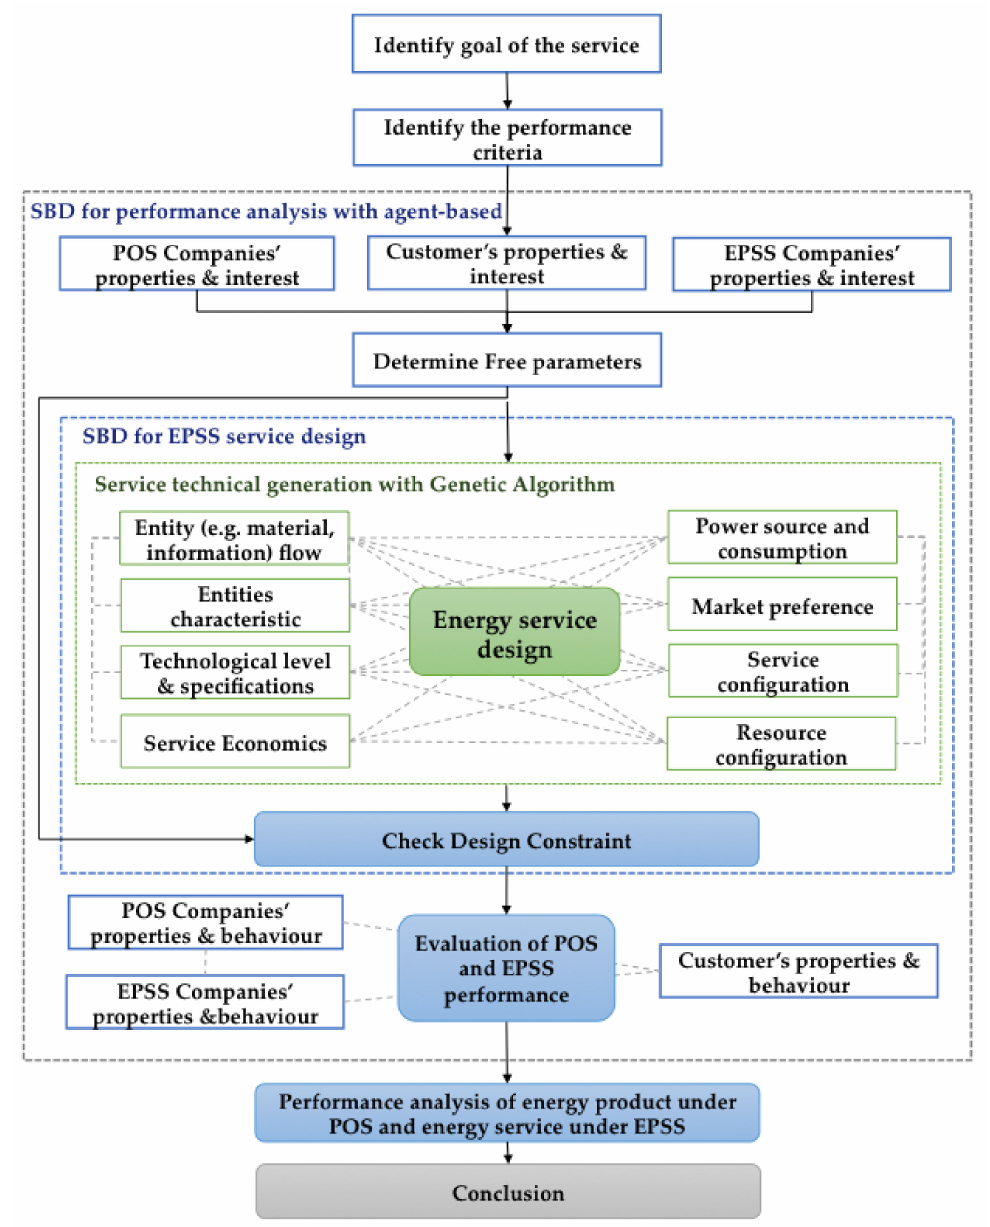
Figure 4. Simulation-Based